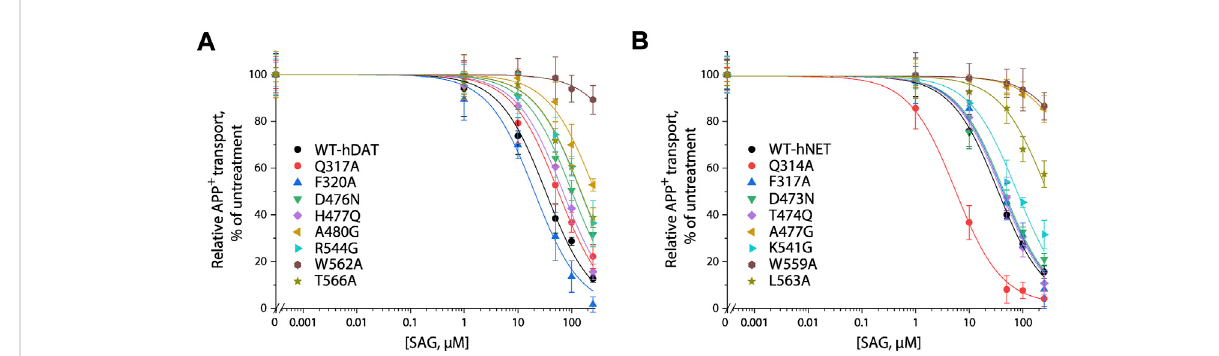
FIGURE 5 SAGinhibitionofAPP + transport byhDAT,hNETandtheirS2sitemutants.APP + transport intothecellsexpressinghDAT, hNET,ortheirmutants was measured over the indicated range of SAG concentrations as described under “ Materials and methods ” . Nonspeci fi c APP + transport was measured in the presence of 10 μ M GBR12909, or 10 μ M desipramine and subtracted to give the values of APP + transport by hDAT or hNET, respectively.GraphsshowrepresentativeexperimentsforSAGinhibitionofWTandmutantsofhDAT (A) ,WTandmutantsofhNET (B) withAPP + transport expressed as a percentage of that measured in the absence of SAG. All error bars represent SDs from at least ten measurements. Experiments were repeated twice more with similar